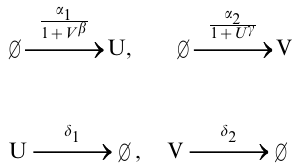
Figure 3. Toggle Switch consisting of double negative feedback loop. Species U represses the production of species V and vice